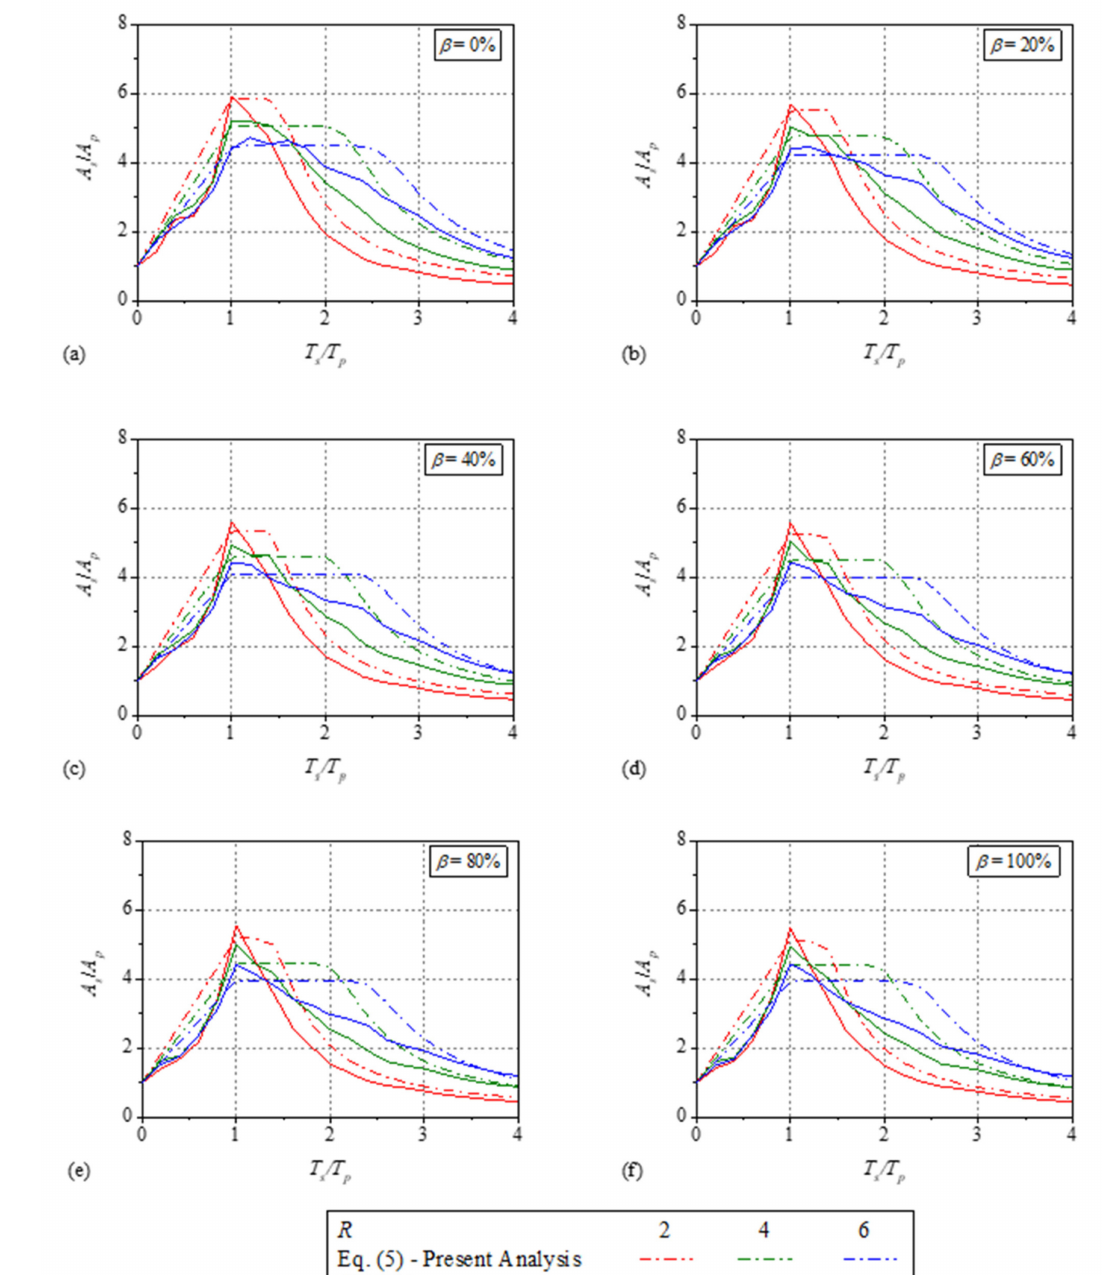
Figure A1. Comparison of the mean normalized floor response spectra from Equation (5) and for a primary structure with initial vibration period T p = 0.5 s: ( a ) β = 0%; ( b ) β = 20%; ( c ) β = 40%; ( d ) β = 60%; ( e ) β = 80%; and ( f ) β =